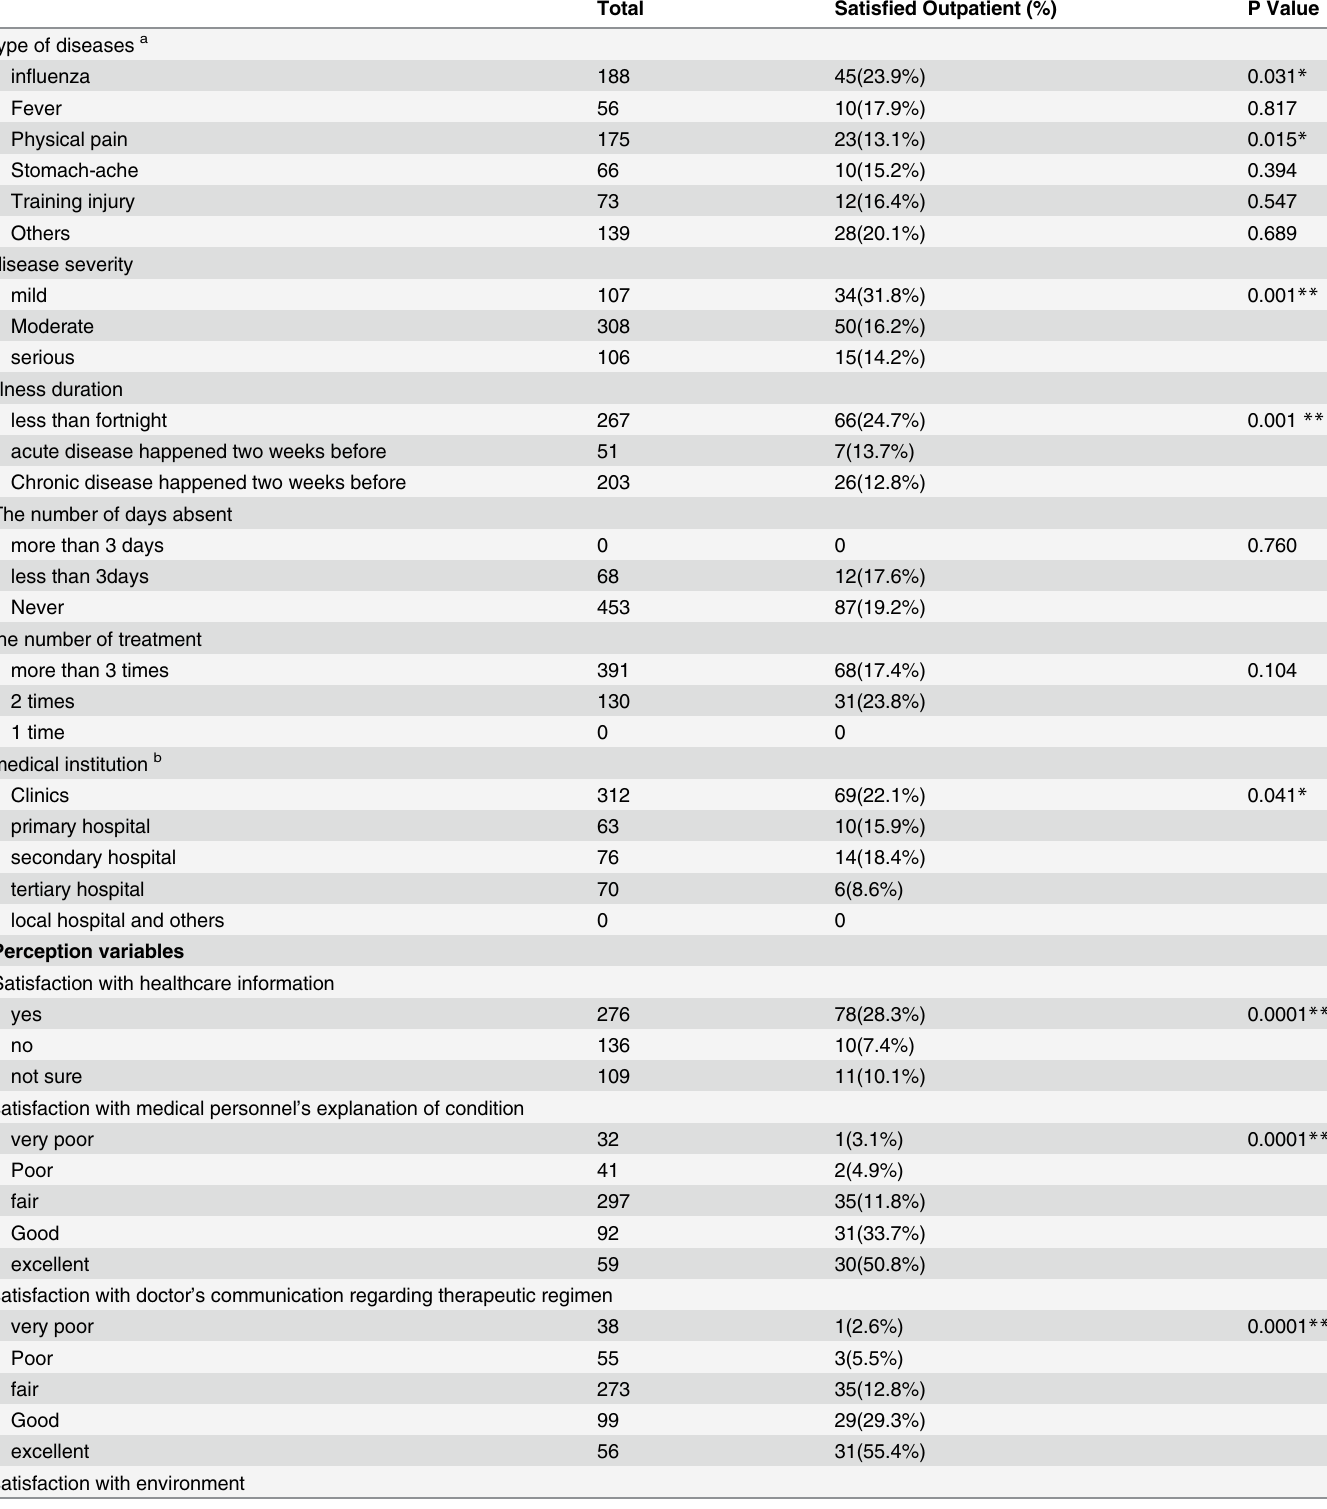
Table 2. The relationship between soldiers ’ satisfaction and illness state, received outpatient care and perception